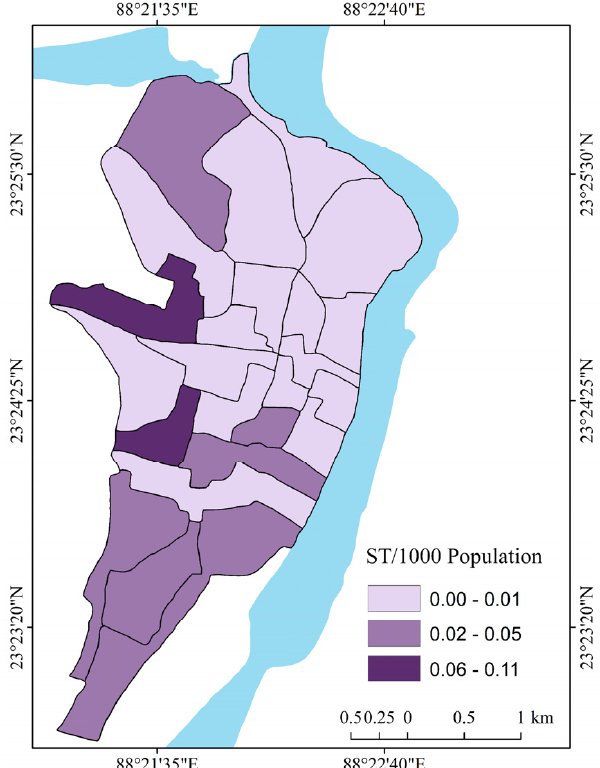
Figure 57. Ward ‐ wise distribution of ST/1000 population in Nabadwip Municipality (2011). Figure 57. Ward-wise distribution of ST/1000 population in Nabadwip Municipality (2011).